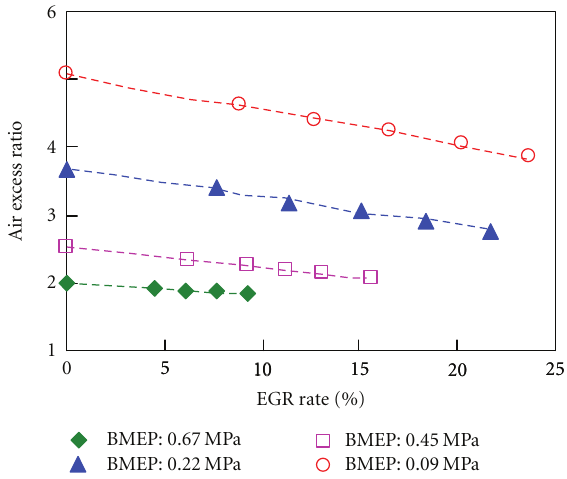
Figure 3: E ff ects of EGR on the air excess